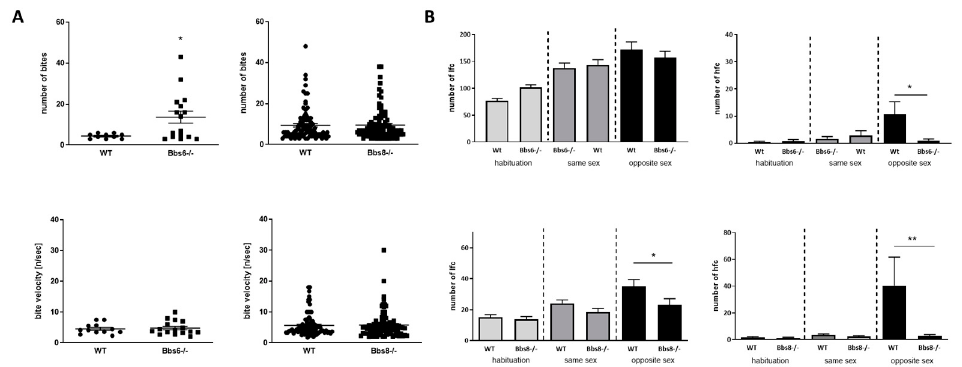
Figure 4. Communication characteristics in Bbs6 and Bbs8 knockout mice. ( A ) Orofacial characteristics as assessed by bite/event counting and bite velocity during the pasta gnawing test ( n = 10 for WT and 16 for Bbs6 − / − ; n = 88 per Wt or Bbs8 − / − ). ( B ) Ultrasonic vocalization evoked by neutral, unused (habituation phase), same sex or opposite sex bedding material (lfc: low frequency calls; hfc: high frequency calls) ( n = 9–10 animals per WT or Bbs6 − / − ; n = 22 animals per WT or Bbs8 − / − ). Student’s unpaired t -test was used for statistical analysis (* p < 0.05; ** p < 0.01).